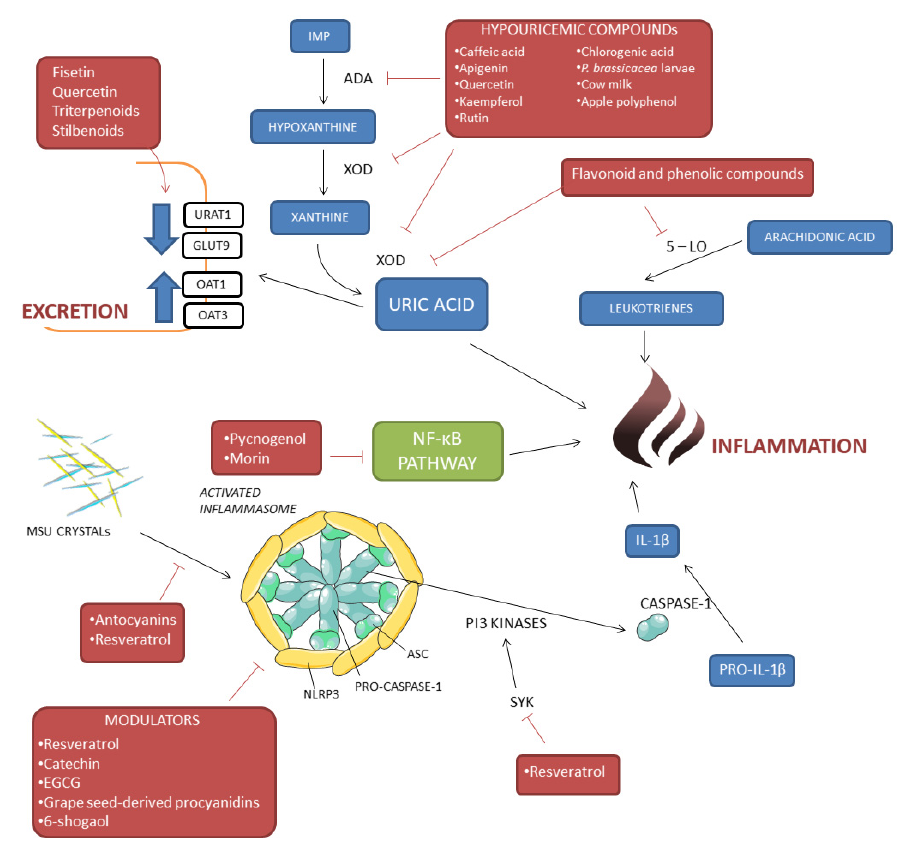
Figure 2. Molecular pathways affected by different bioactive compounds. Bioactive molecules can decrease uric acid levels acting on XOD and ADA enzymes, or hindering inflammation associated with MSU crystals